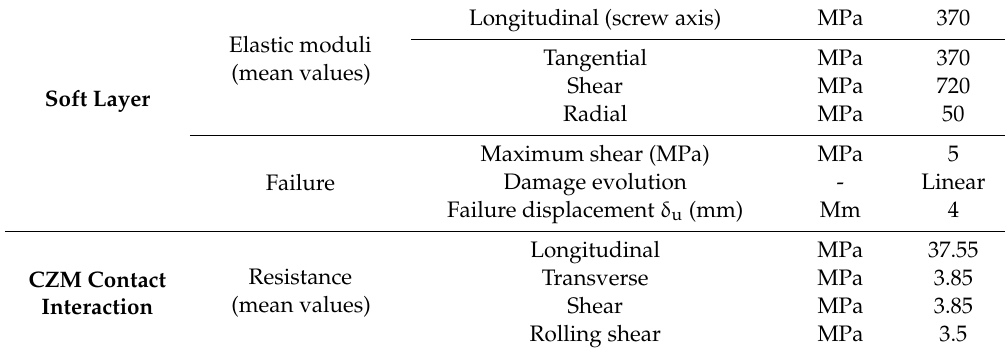
Table 2. Input mechanical properties for the soft layer and for the CZM contact interaction (ABAQUS / Explicit).